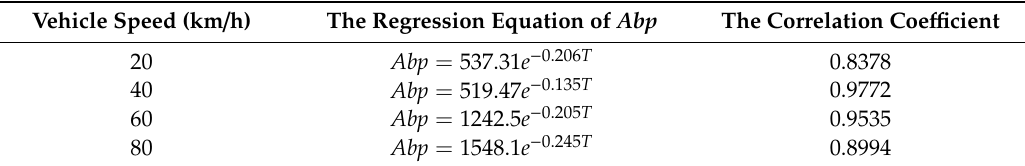
Table 5. The regression equation of Abp at di ff erent